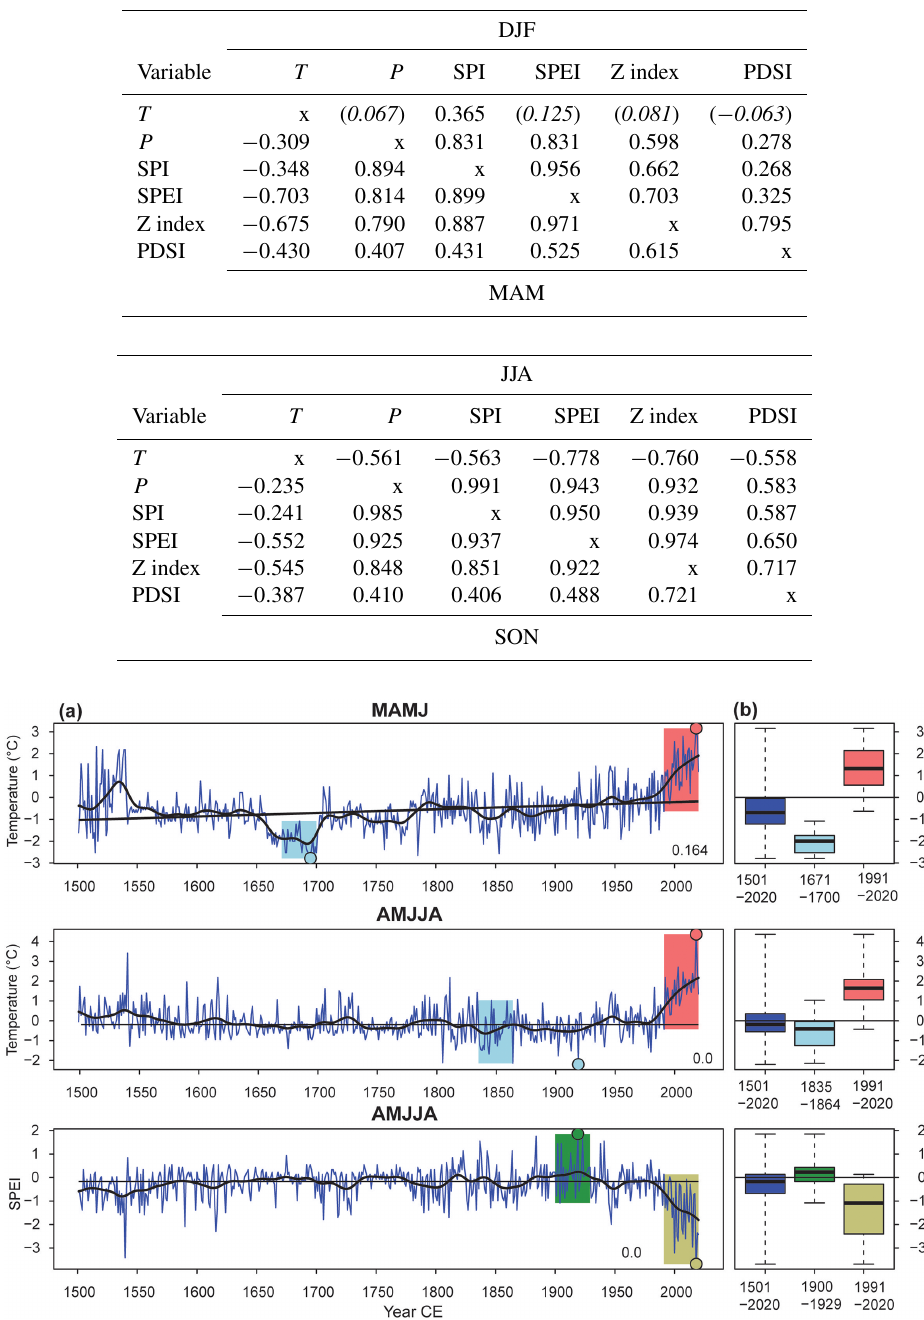
Figure 7. (a) Variability of MAMJ mean temperatures reconstructed from the winter wheat harvest dates (Možný et al., 2012) as well as AMJJA mean temperatures and SPEI reconstructed from the grape harvest dates (Možný et al., 2016a, b) in the Czech Lands during the period of 1501–2020CE. Annual values are completed with the 30-year Gaussian filter, linear trends, and their numeric values (temperature: ◦ C per 100 years, SPEI: index value per 100 years); extreme 30-year periods of each series are indicated by coloured bands and the lowest and highest values of series by small circles. (b) Box plots express the median, lower and upper quartile, minimum, and maximum for 1501–2020 and the two most extreme 30-year periods. Temperature series are expressed as deviations with respect to the 1961–1990